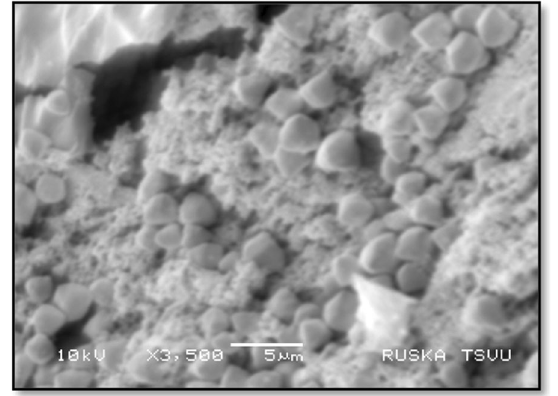
Spilosoma obliqua polh = S. =